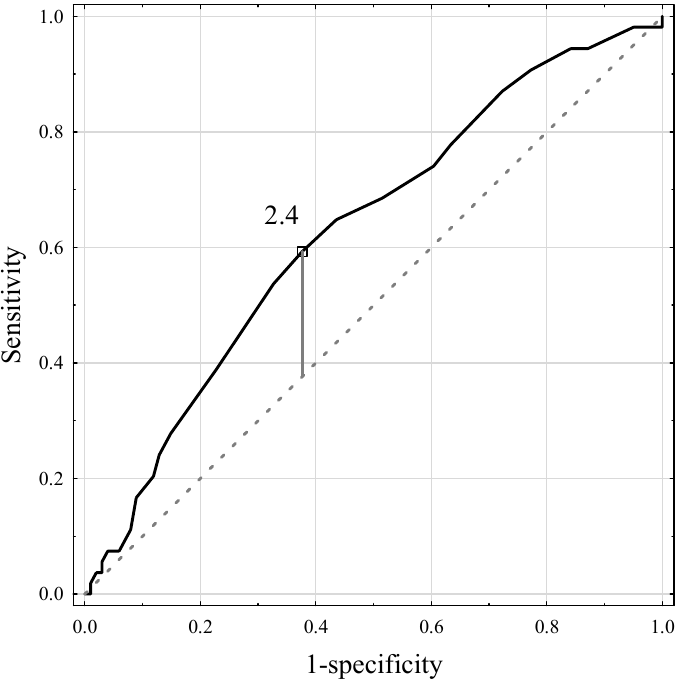
Figure 4. The ROC curve for the skin autofluorescence measurements and macrovesicular steatosis > 10%.